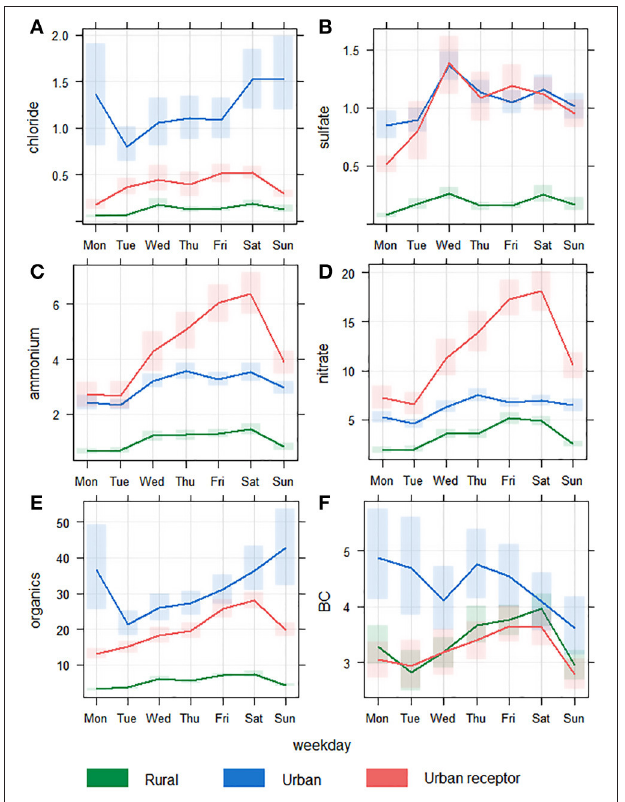
FIGURE 10 | Weekly temporal profile of 1-h average concentrations ( µ g m − 3 ) during the spring season. (A) chloride, (B) sulfate, (C) ammonium, (D) nitrate, (E) organics, (F) black carbon. Mean (solid line) and 95% confidence intervals in the mean (transparent